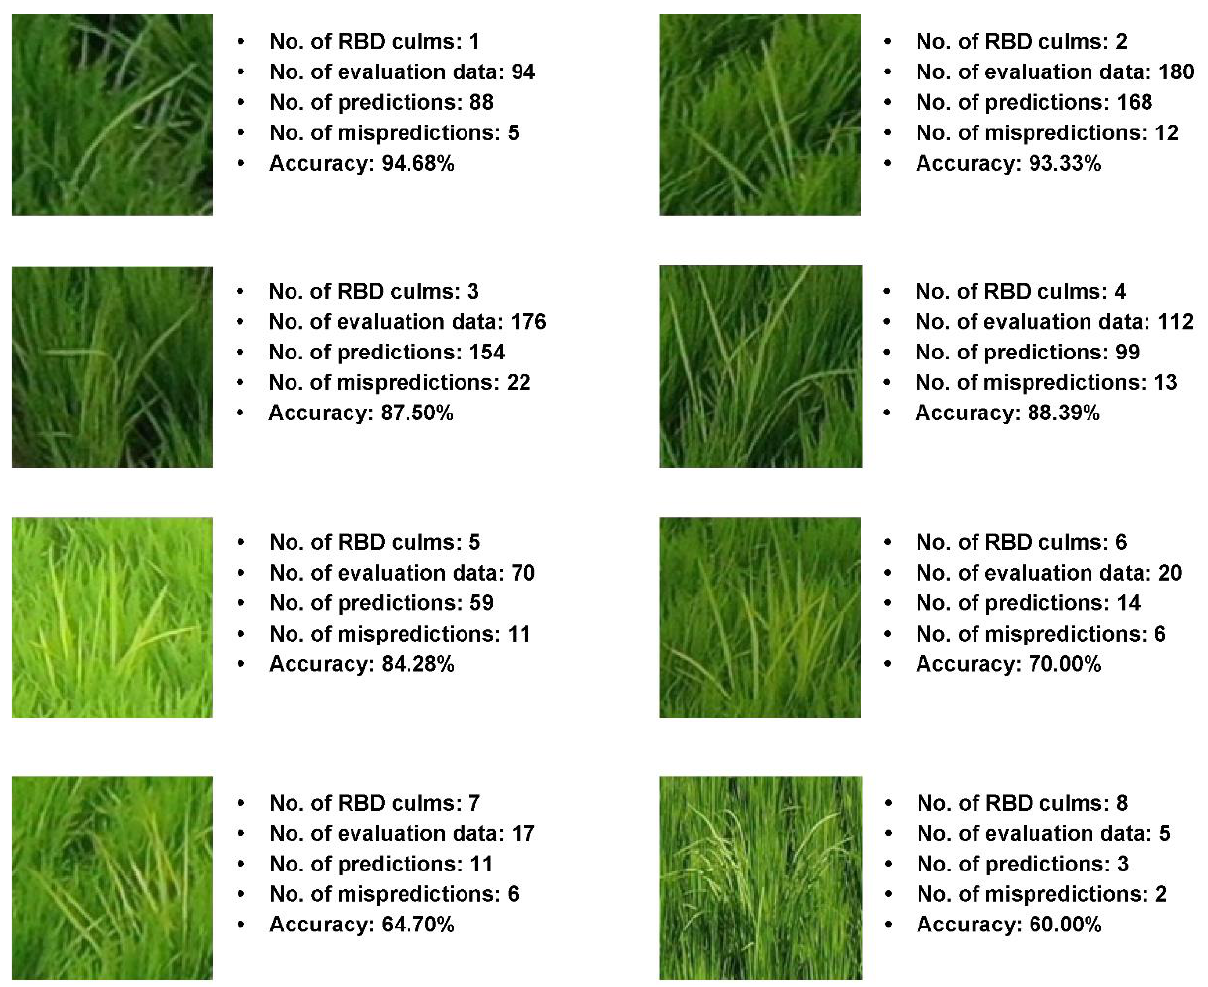
Figure 21. The prediction result of RBD for 50 layers of deep residual network. Table 10. The reconstructed number of RBD infected culm classification training and evaluation datasets.